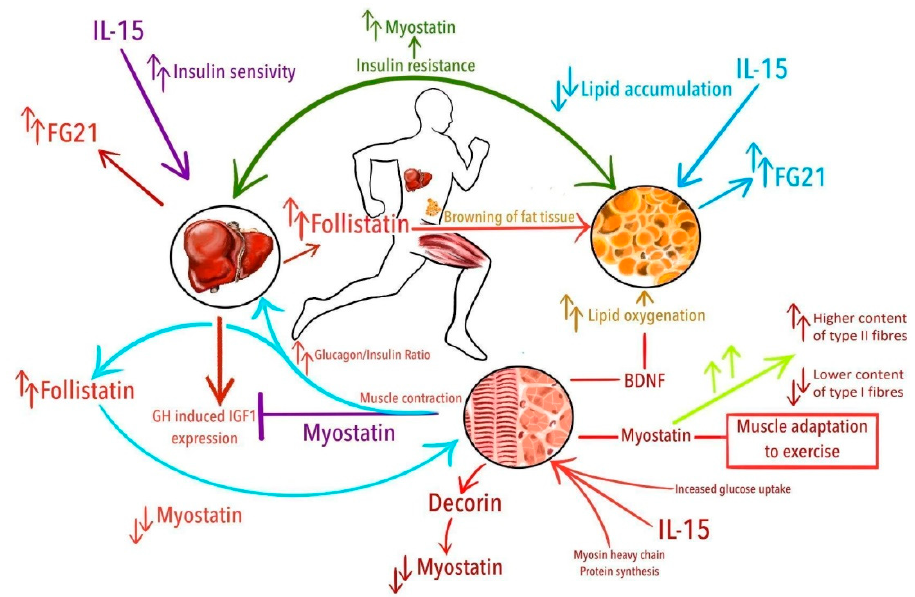
Figure 1. Potential relations of exercise-induced cytokines with physical activity and accompanying phenomena. From the top in clockwise manner: Overall insulin resistance is related with increased levels of myostatin; IL-15 decreases lipid accumulation; muscle-contraction induced increase of brain-derived neurotrophic factor (BDNF) drives lipid oxygenation; increased levels of myostatin are related with higher content of type II fibers and lower content of type I fibers and probably are associated with muscle adaptation to exercise; interleukin 15 (IL-15) stimulates synthesis of myosin heavy chain proteins and increase glucose uptake in the muscle; decorin binds with myostatin and downregulates its activity; in the liver, myostatin suppresses growth hormone (GH)—induced insulin-like growth factor 1 (IGF-1) expression; increased glucagon/insulin ratio after exercise leads to increased production of follistatin in the liver, which suppress myostatin activity; fibroblast growth factor 21 (FGF21) is produced mainly by the liver; IL-15 improves insulin-sensitivity; follistatin promotes browning of white adipose tissue.